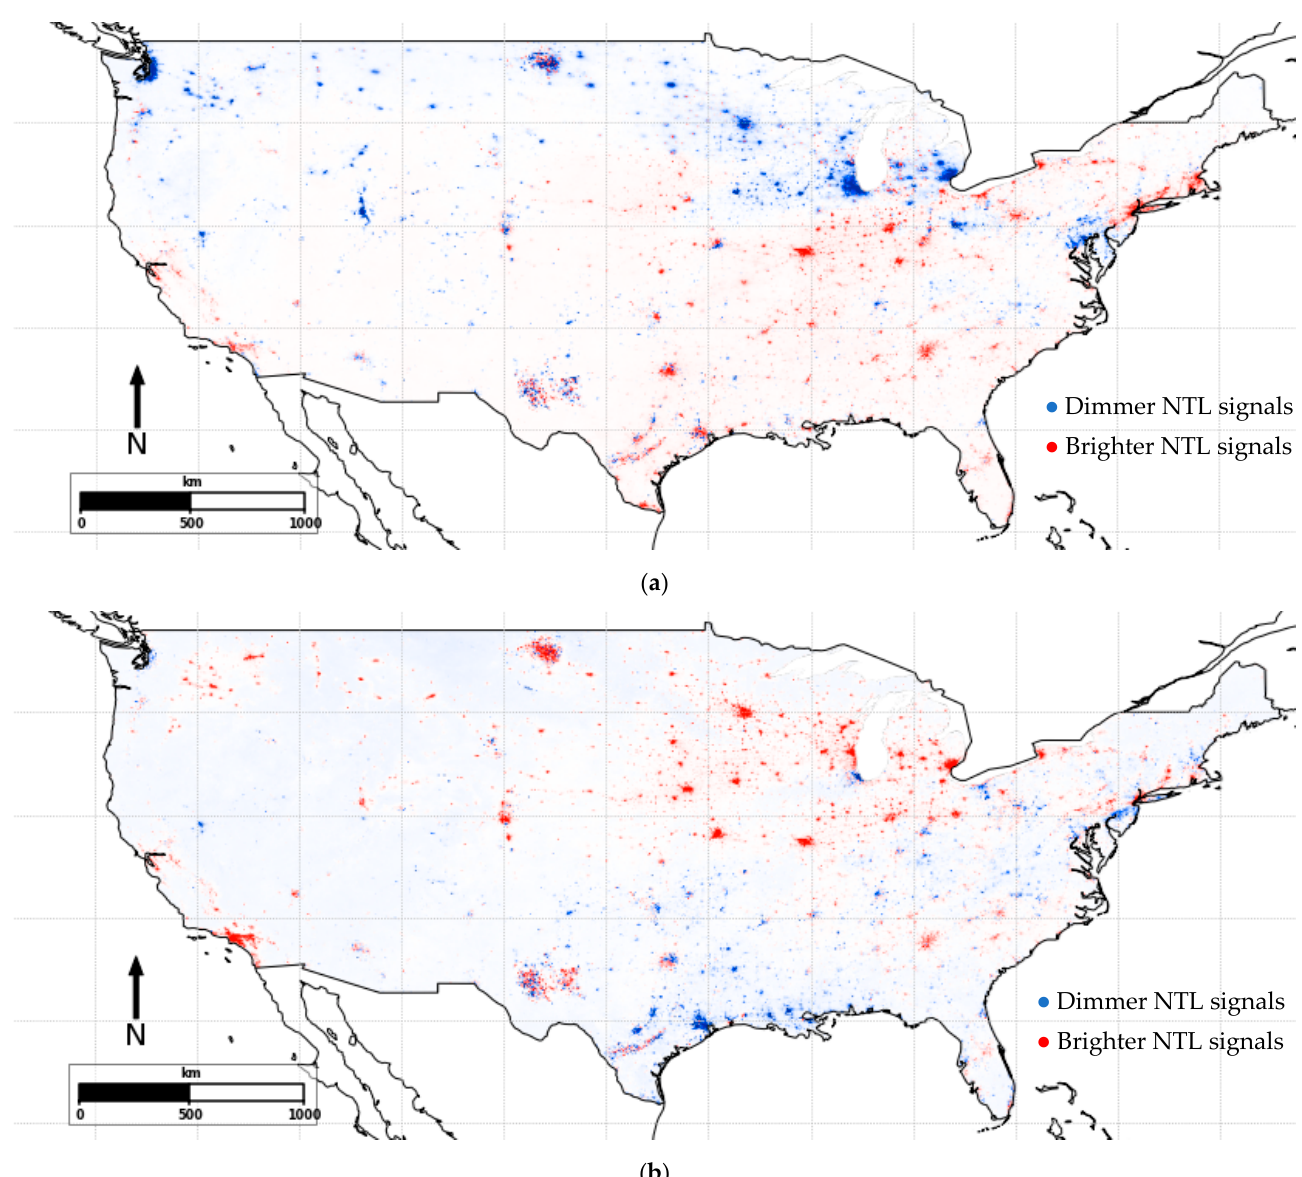
Figure 2. Changes in night lights before the COVID-19 pandemic: March 2019 vs. February 2019 ( a ) and March 2019 vs. March 2018 ( b ). Blue and red pixels stand, respectively, for dimmer and brighter NTL signals . Source: Authors’ calculations based on VIIRS data from the Earth Observation Group and Google Earth Engine [32].